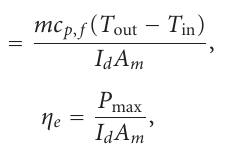
Figure 3: The setup of the TCPV/T